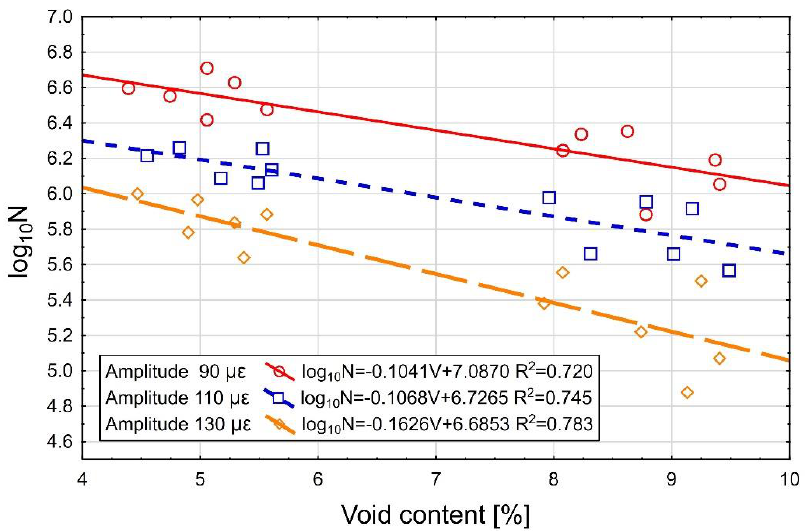
Figure 12. The effect of the air void content in AC 16 W 35/50 asphalt concrete on the fatigue life of the layer (log 10 N) for the strain amplitudes of 130, 110 and 90 μm/m.